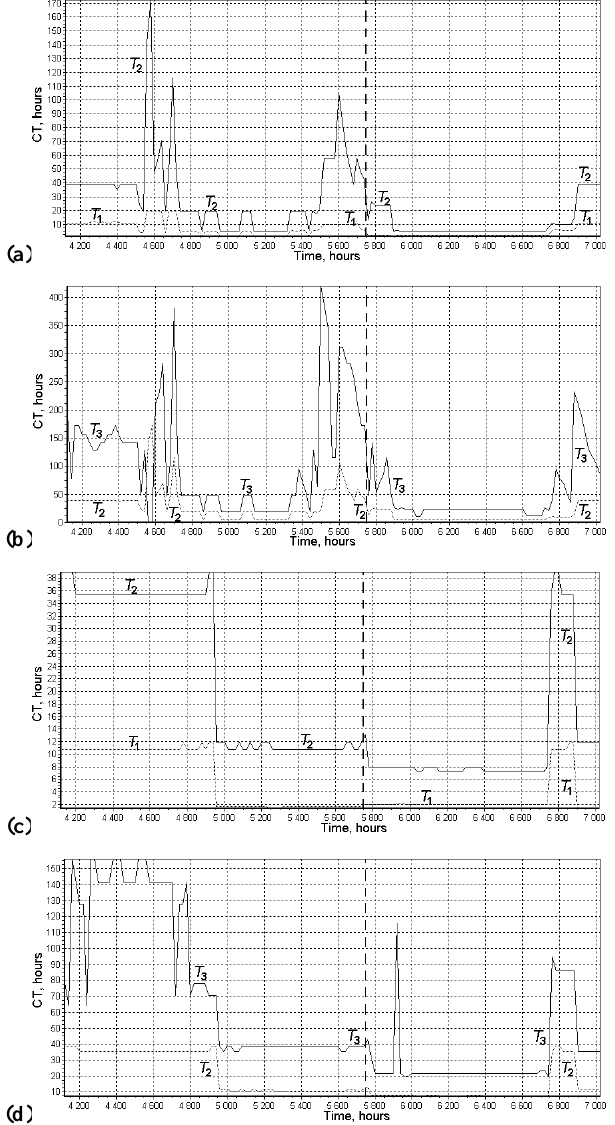
Fig. 3. Results of calculation CTs T 1 , T 2 (a, c) and T 2 , T 3 (b, d) by sensors 2 (a, b) and 3 (c, d) data. Earthquake is marked by dotted line.